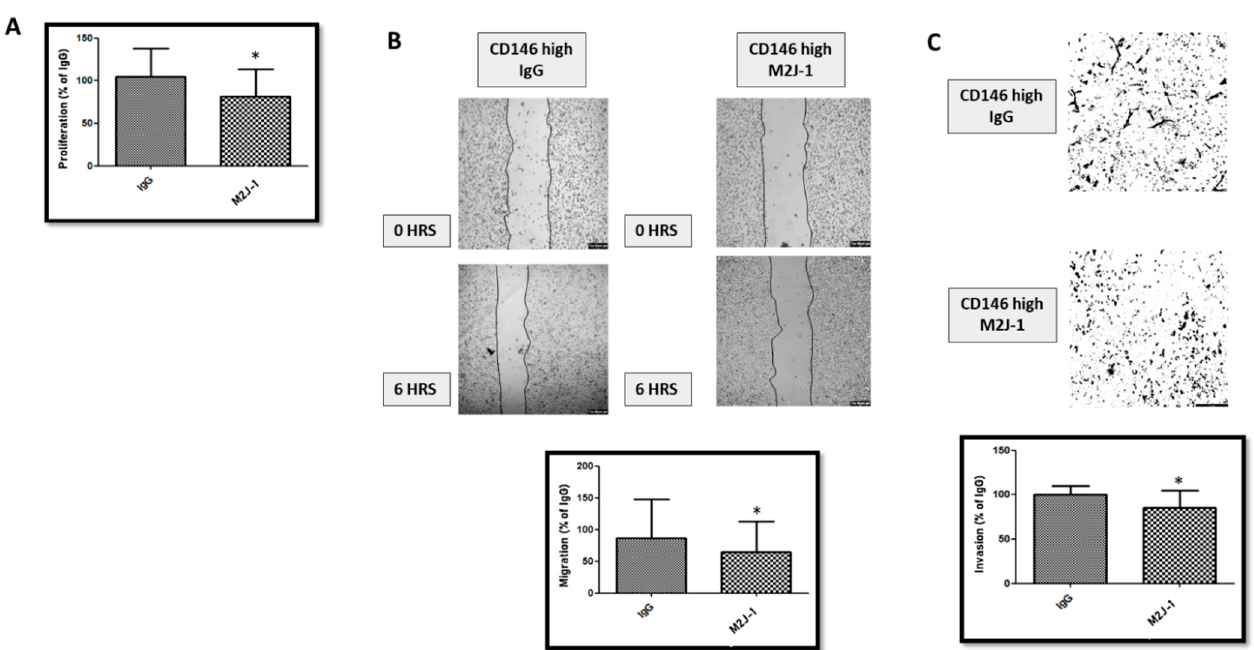
Figure 5. Effect of M2J ‐ 1 antibody on the proliferation, migration and invasion in CD146 high MDA ‐ MB ‐ 231. ( A ): Effect of M2J ‐ 1 antibody on proliferation as compared to control IgG. ( B ): Effect of M2J ‐ 1 antibody on migration as compared to control IgG. Images show representative pictures of the migration assay, and the average of five experiments is given. ( C ): Effect of M2J ‐ 1 on invasion as compared to control IgG. Images show representative pictures of the invasion assay, and the average of five experiments is given. *: p < 0.05, M2J ‐ 1 vs. IgG.